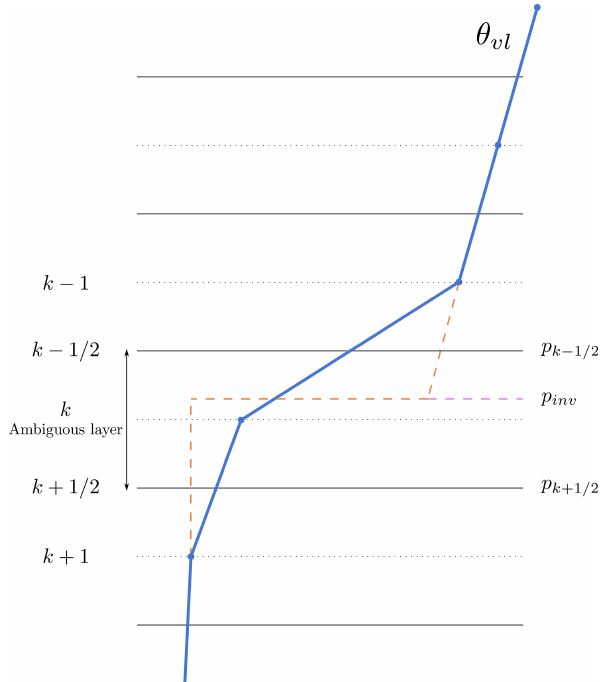
Figure 2. Illustration of a θ vl profile (blue line) and its sub-grid re- construction (dashed orange line) in the ambiguous layer. The solid and dotted horizontal black lines are the model half-levels and full- levels respectively. The dashed lines extending from levels k + 1 and k − 1 represent the assumed sub-grid θ vl profile within the ambigu- ous layer and are obtained as described in Sect. 2.2.2. The disconti- nuity in the sub-grid profile constitutes the inversion pressure p inv